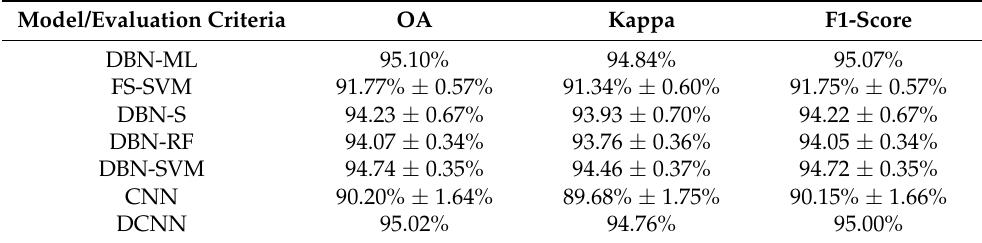
Table 4. Comparison of performance results of different models on test